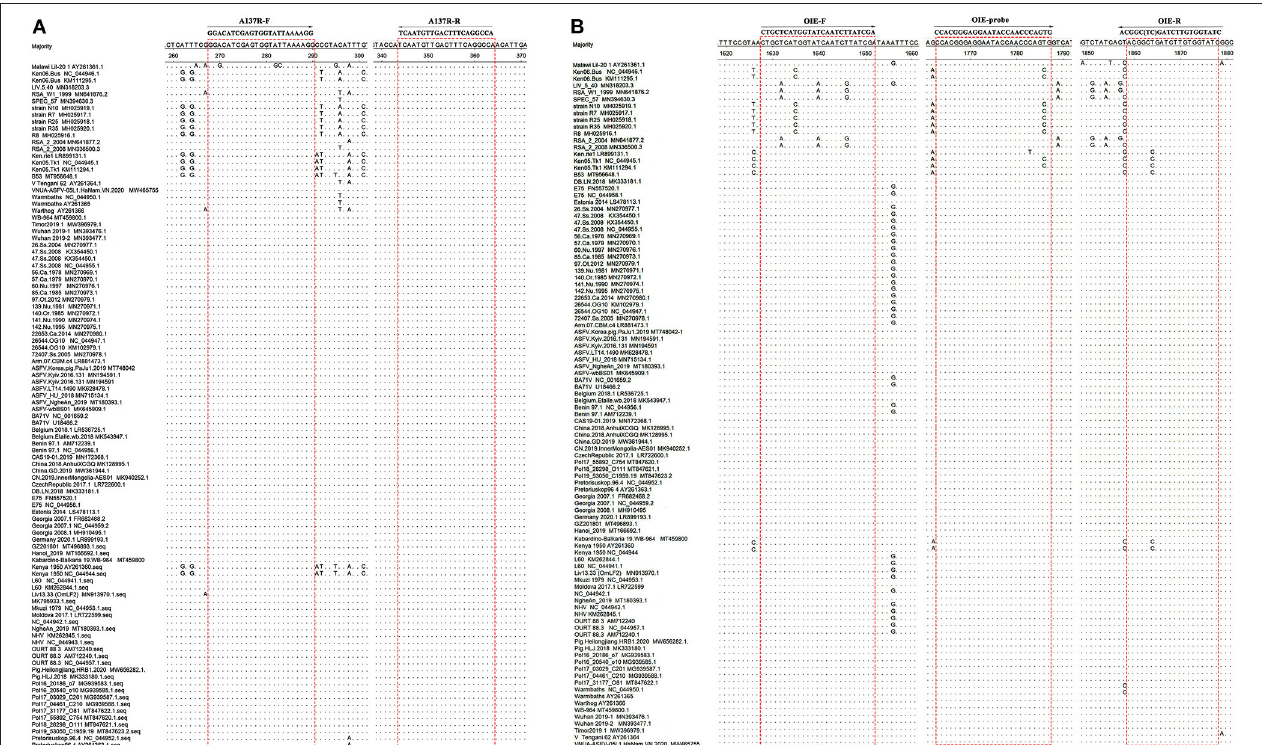
FIGURE 1 | Alignment of sequences of the ASFV A137R gene and B646L gene in GenBank. (A) Locations of the target sequences of the primers A137R -F/ A137R -R designed in the present study. (B) Locations of the target sites of the primers OIE-recommended TaqMan PCR method ( 19). Dots (.) indicate identical bases. The primer-binding sequences are